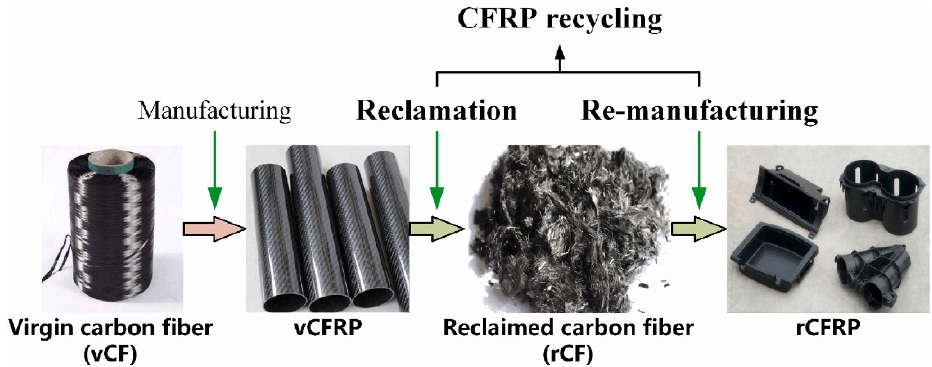
Figure 3. Recycling Process from Virgin Carbon Fiber to CFRP.